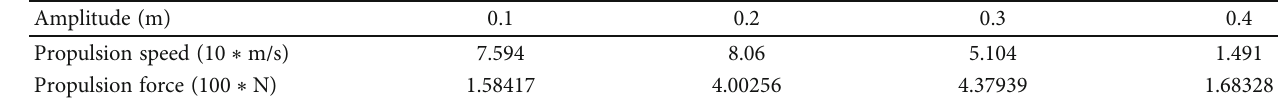
Table 2: E ff ect of maximum amplitude.